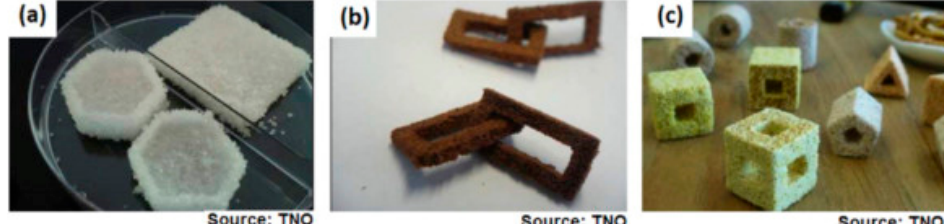
Figure 3. Examples of 3D printing technique based on SLS technology: ( a ) sugar, ( b ) Nesquik, and ( c ) curry cube, paprika pyramid, cinnamon cylinder, and pepernoot pentagon constructs. Picture taken from an article by Godoi et al. [25].